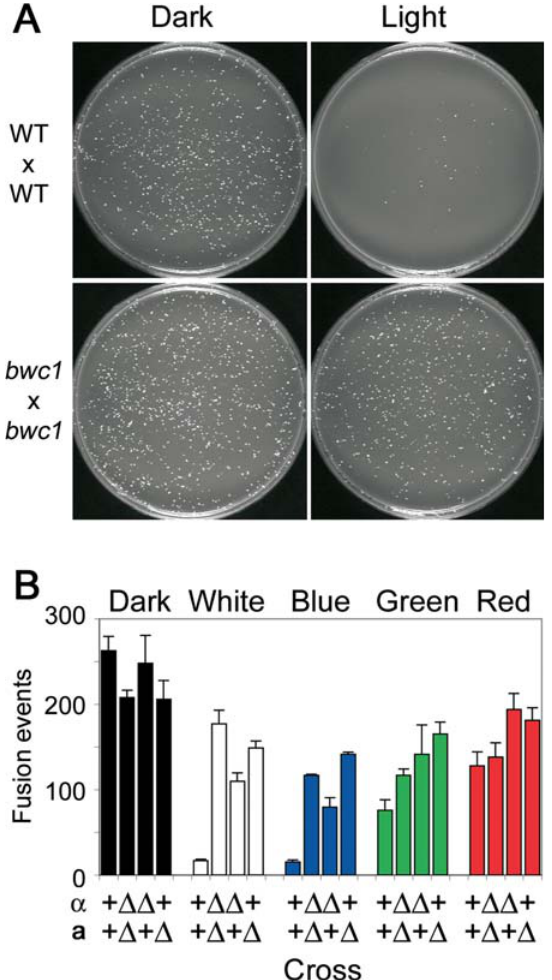
Figure 2. Bwc1 Regulates Fusion of C. neoformans Cells in Response to Blue Light (A) Auxotrophic strains that were wild type (WT) or bwc1 mutant were mated on V8 medium for 24 h and plated onto minimal medium to select for dikaryotic strains that result from cell fusion events. Light inhibits fusion in wild-type strains, and this inhibition is absent in bwc1 mutant strains. (B) Fusion efficiency of strains under different wavelengths of light. Fusion is reduced by white or blue light. Matings were between wild- type ( þ ) parents, bwc1 mutant ( D ) parents, or one wild-type and one mutant parent ( bwc1 a 3 WT a , or WT a 3 bwc1 a ). Mutation of bwc1 in either or both mating partners relieves inhibition of fusion by white or blue light. Bars indicate the standard error of the mean of three